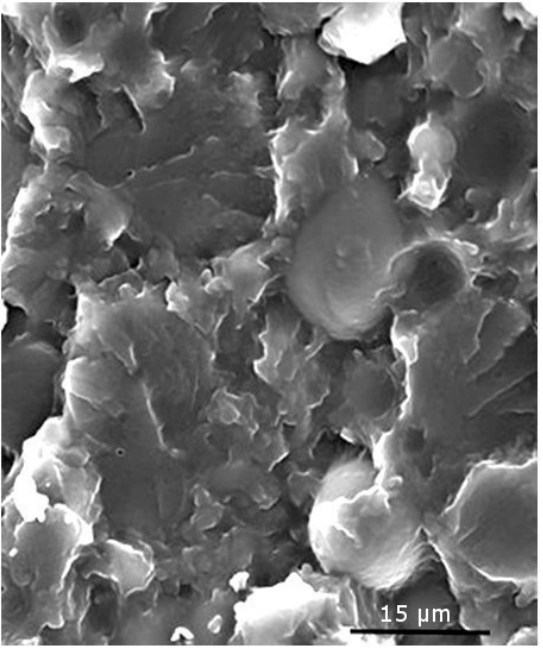
Figure 7. SEM picture of the product obtained after 30 min of reaction prepared in mini twin-screw extruder in the conditions as described for run